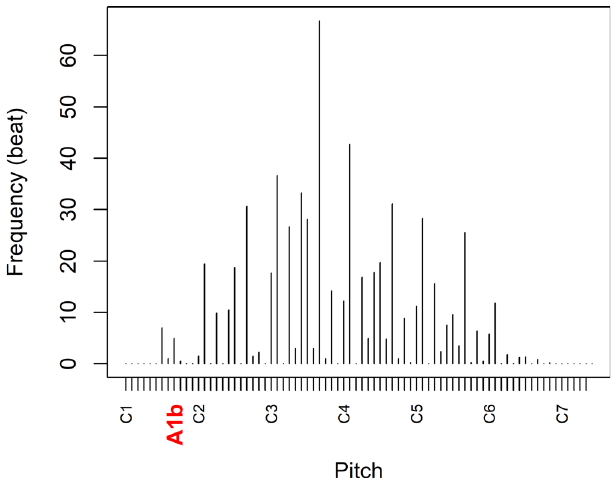
Figure 1. Unfolded pitch histogram of the andante of sonata No. 23, the so called “ Appasionata ”